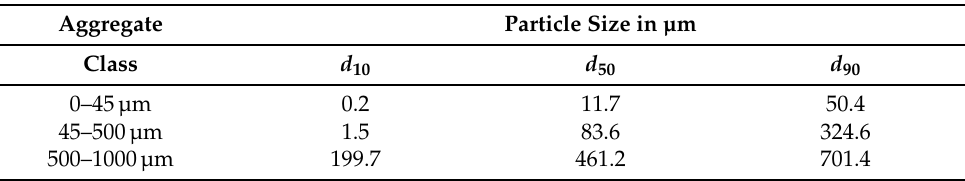
Table 3. Characteristic particle sizes of three synthesised composite aggregate classes measureable by laser granulometry.